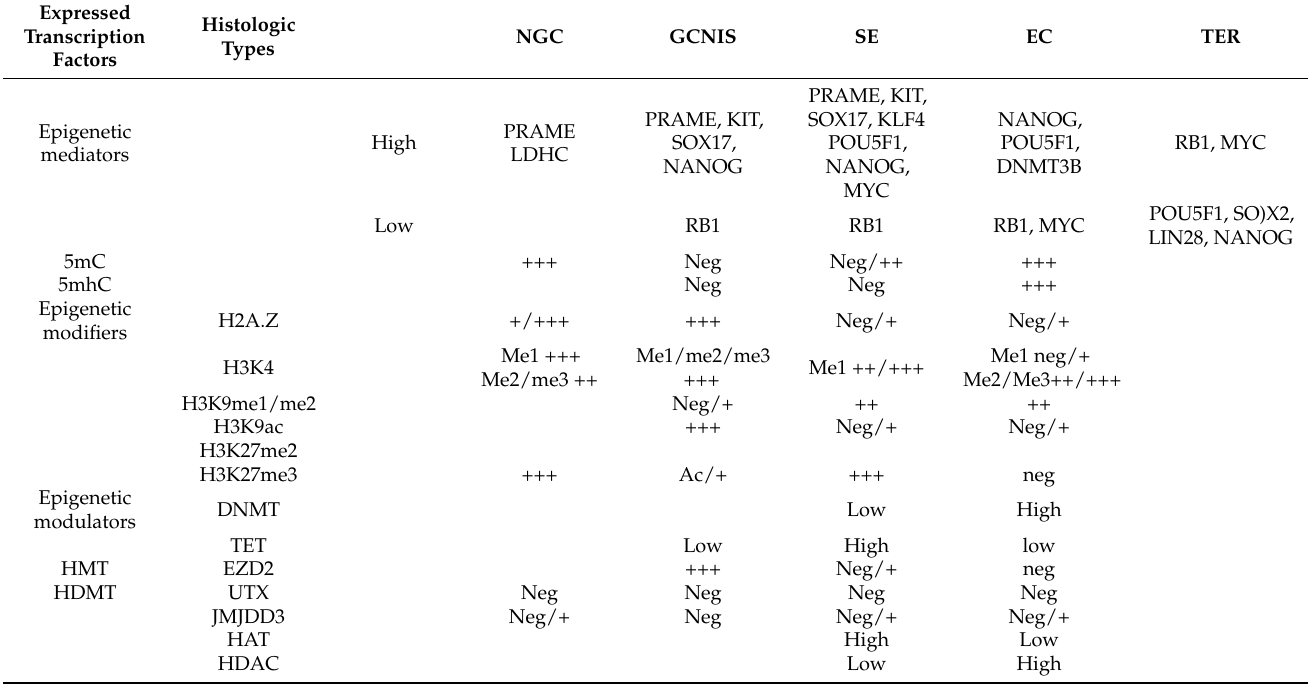
Table 1. Histologic types of TGCT and epigenetic